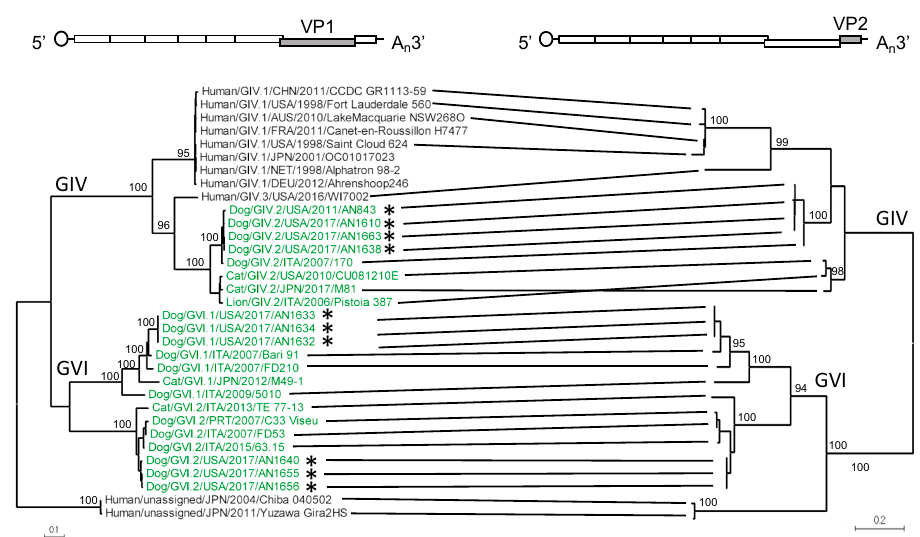
Figure 2. Phylogenetic analyses of GIV and GVI norovirus major (VP1) and minor (VP2) capsid proteins reveal clustering into distinct lineages and suggest their co-evolution. Maximum likelihood tree of the complete aa sequence of VP1 based on the Jones-Taylor-Thornton (JTT) matrix-based model. The phylogenetic tree was calculated with MEGA software (version 7.0.18). Strains described in this study are labeled with an asterisk (*). Strains highlighted in green and black represent animal and human noroviruses, respectively. Co-evolution is indicated by connecting strains from each of the phylogenetic trees. A diagram of the genome indicating the region used for the analyses (light grey) is shown on top.